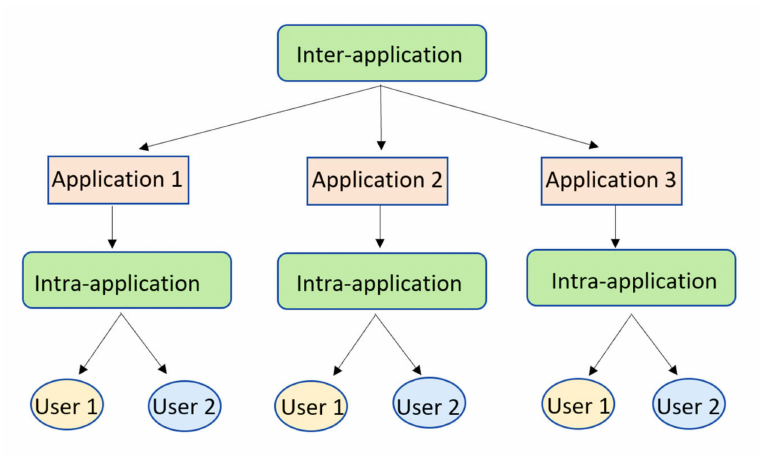
Figure 1. Inter-application and intra-application